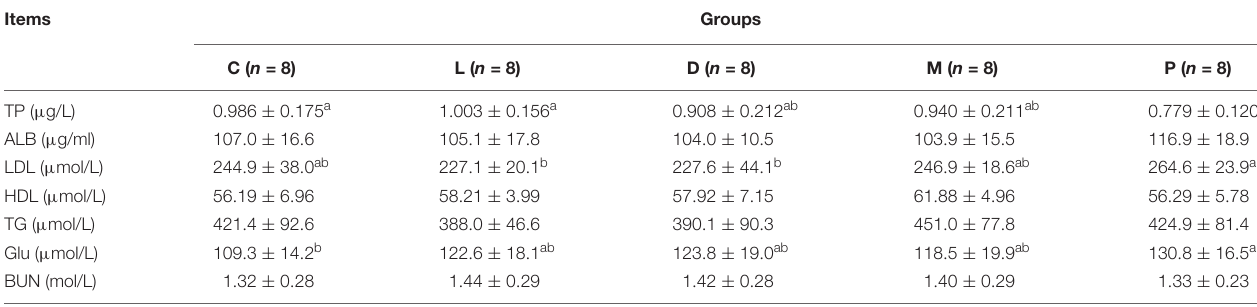
TABLE 4 | Effects of different calcium sources on plasma biochemical indexes of weaned piglets. Items Groups